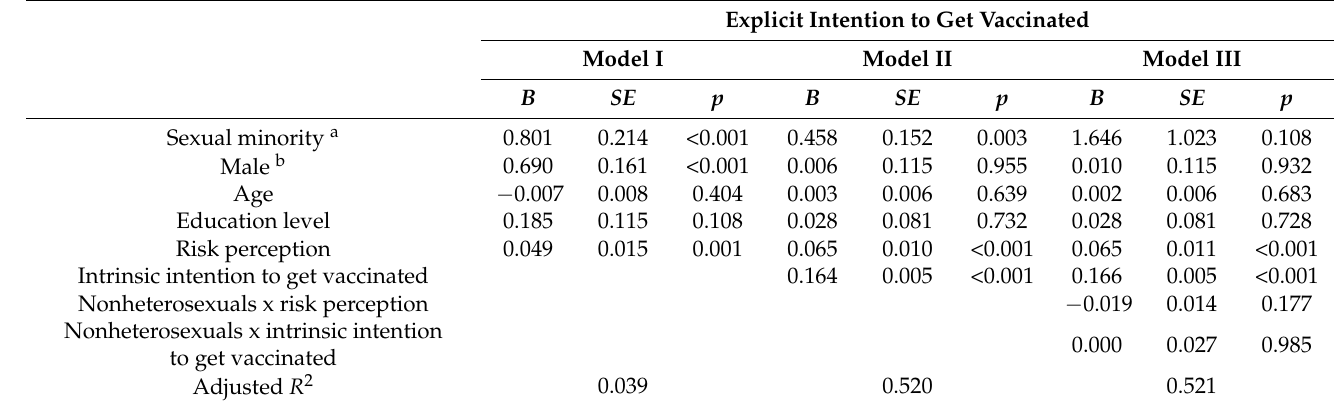
Table 3. Multiple regression analysis of factors related to intention to receive COVID-19